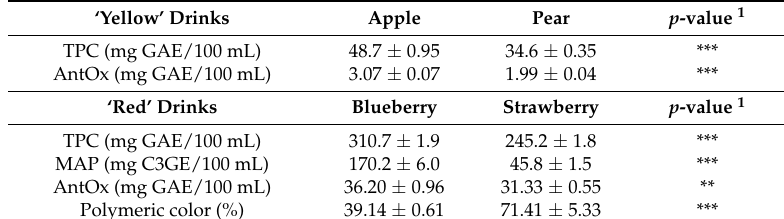
Table 6. Total phenolic content (TPC), antioxidant activity (AntOx) total monomeric anthocyanin content (MAP) and percent polymeric color of RCW-fruit drinks before pasteurization (TQ samples) and significance of Student’s t test ( p